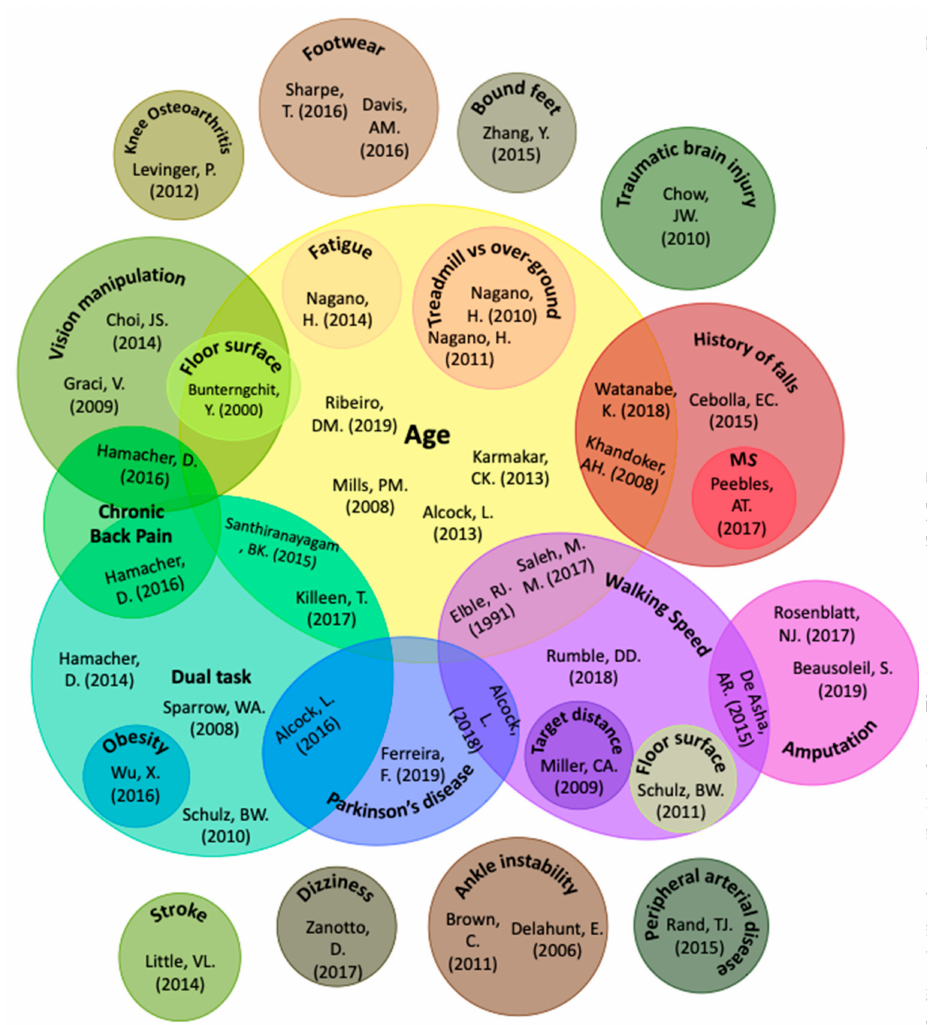
Figure 3. Conditions assessed in literature for effect on minimum foot